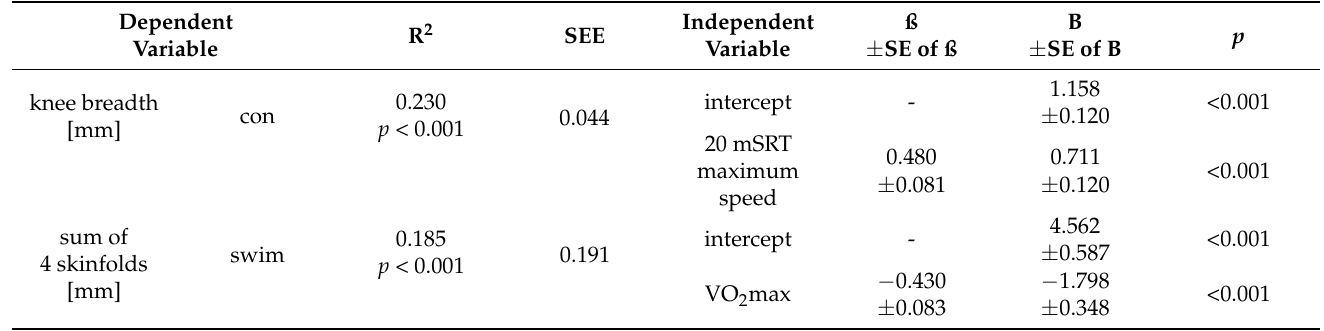
Table 6. The results of a stepwise multiple regression analysis with backward elimination for dependent variables: knee breadth and the sum of four skinfold thicknesses (subscapular, suprailiac, biceps, and triceps) in regard to the number of running shuttles performed during the 20 mSRT, maximum 20 mSRT speed, and VO 2 max calculated of the basis of results of 20 mSRT as independent variables for control and swimming group,